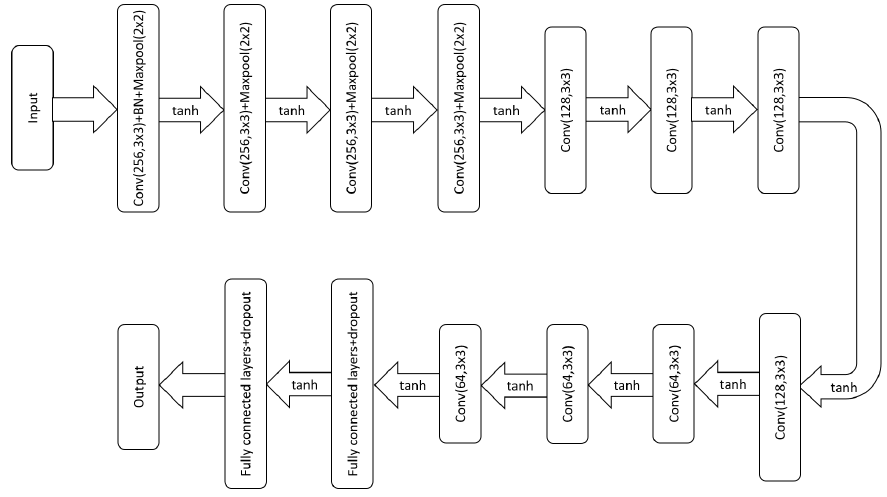
Figure 6. Deep learning network model.